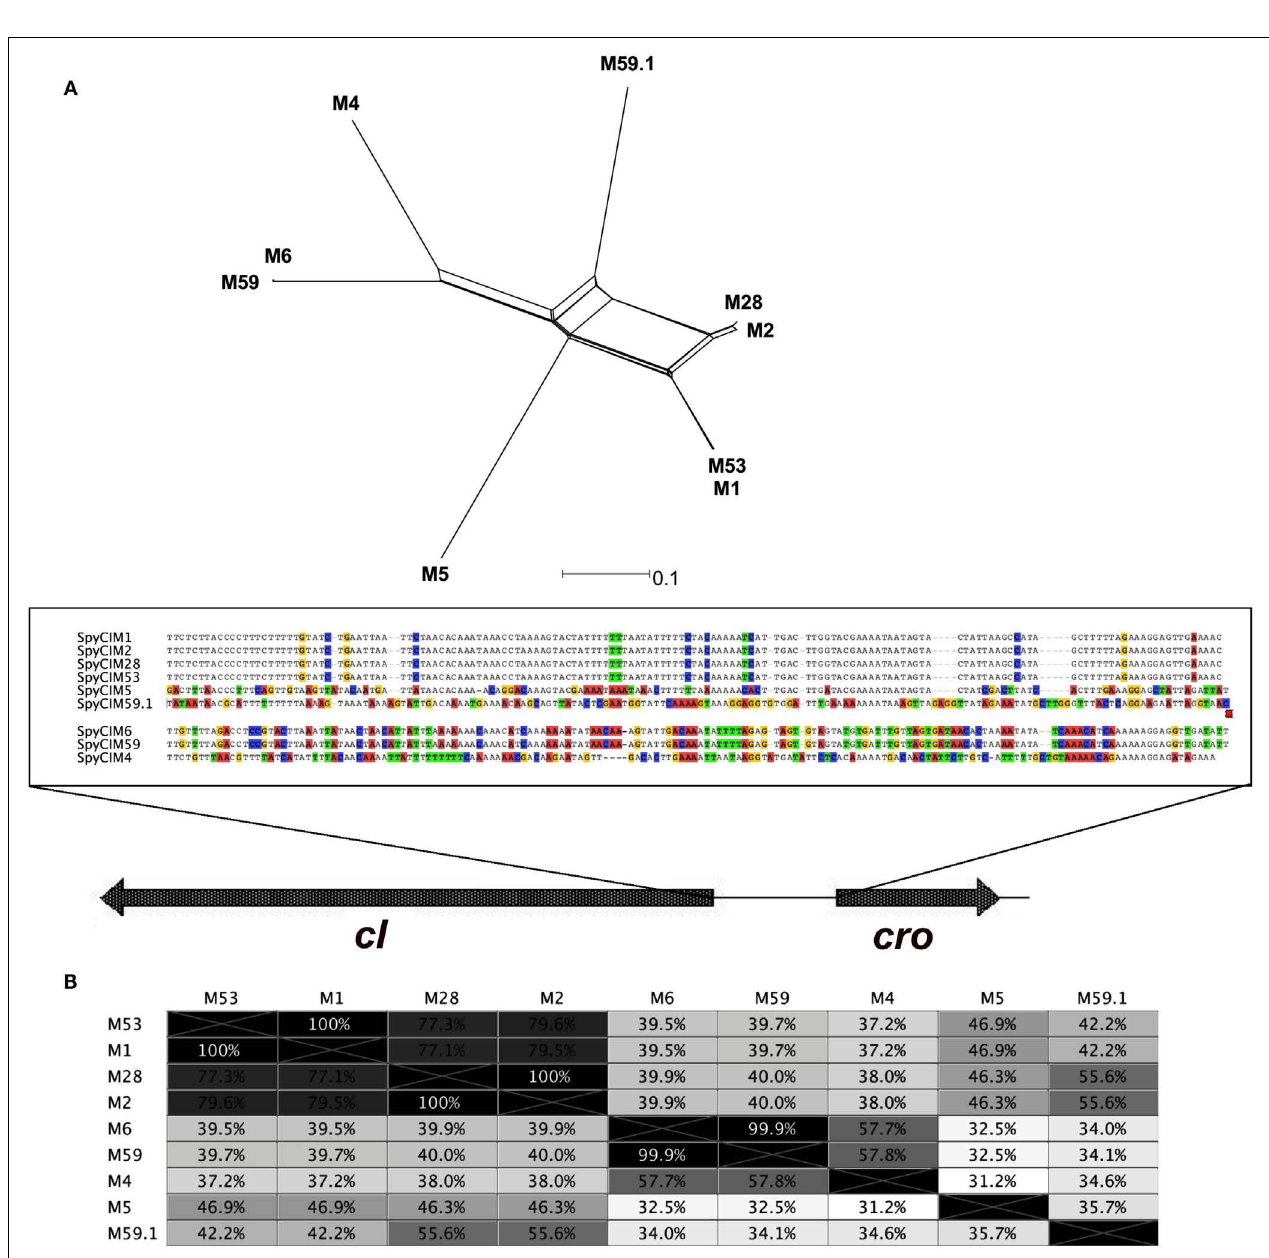
operator regions; variants from the consensus are colored by nucleotide. The SpyCI regions analyzed were from strains SF370 (M1), MGAS10270 (M2), MGAS10750 (M4), Manfredo (M5), MGAS10394 (M6), MGAS6180 (M28), Alab49 (M53), MGAS15252 (M59), and MGAS1882 (M59.1). (B) Shown is the identity matrix for the DNA alignment of the SpyCI repressor-operator